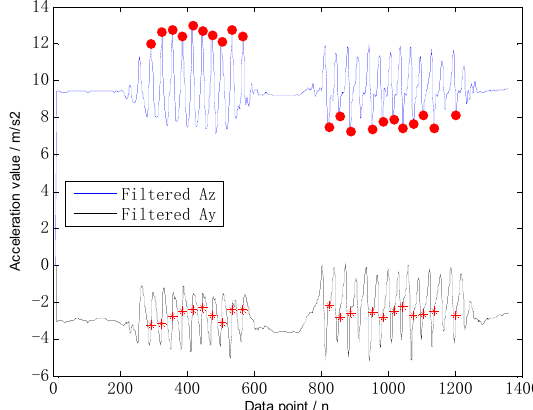
Figure 3. Comparison of walking forward and backward.